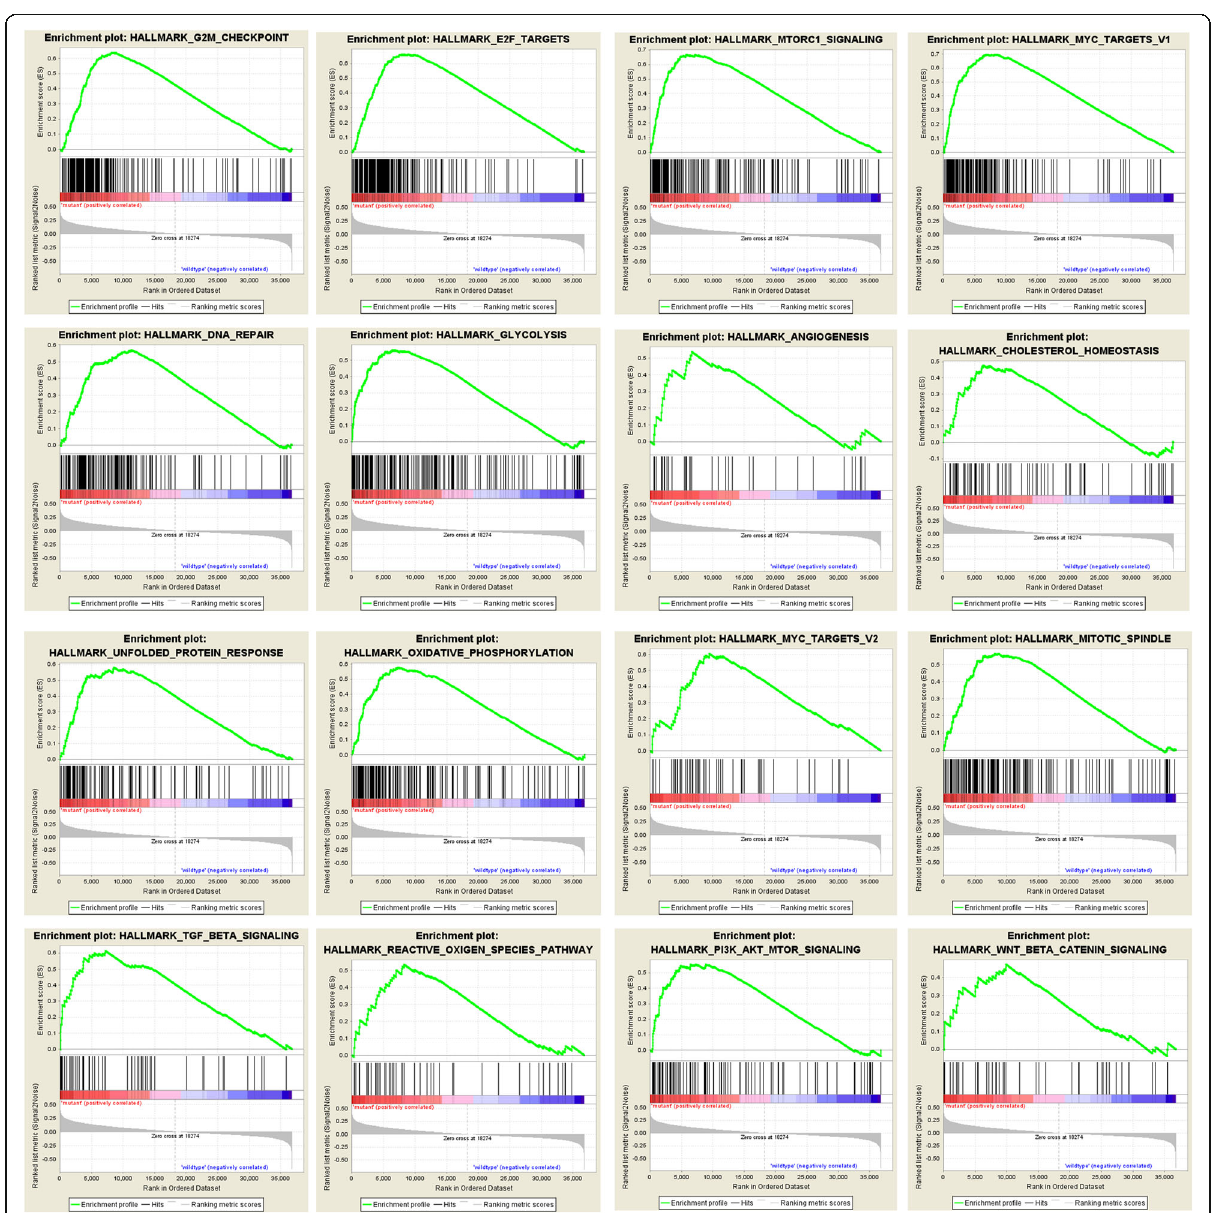
Fig. 2 GSEA results showed primary biological functional gene sets enriched in PTEN mutation prostate cancer patients, including G2M check point, E2F targets, mTORC1 signaling pathway, MYC target, DNA repair, glycolysis, angiogenesis, cholesterol homeostasis, unfolded protein response, oxidative phosphorylation, mitotic spindle, TGF- β pathway, reactive oxygen species pathway, PI3K-AKT-mTOR signaling pathway